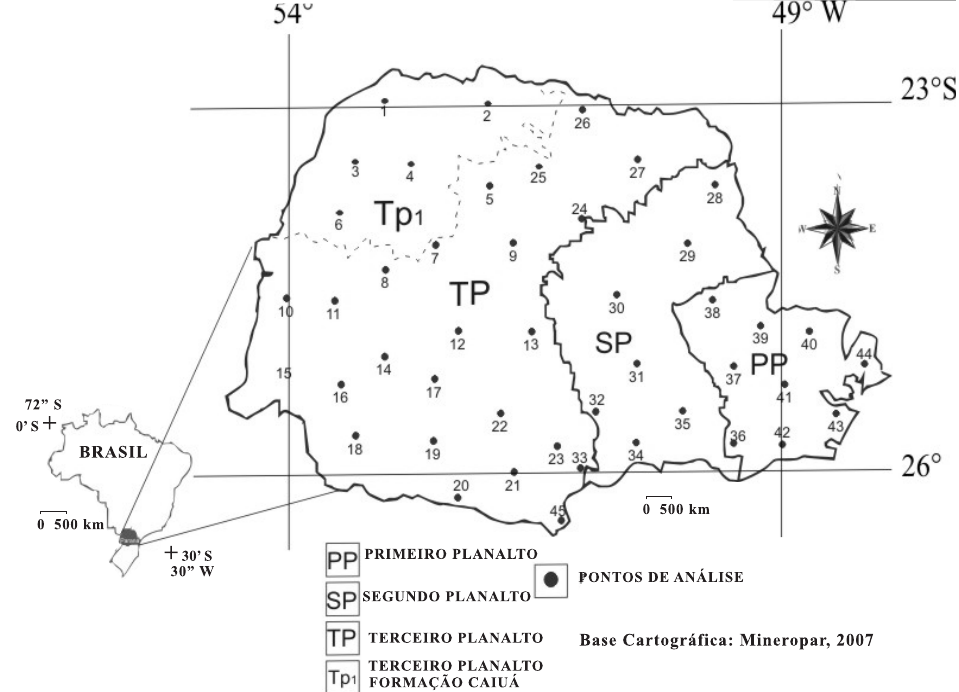
Figura 1. Localização da área de estudo e dos pontos de coleta das